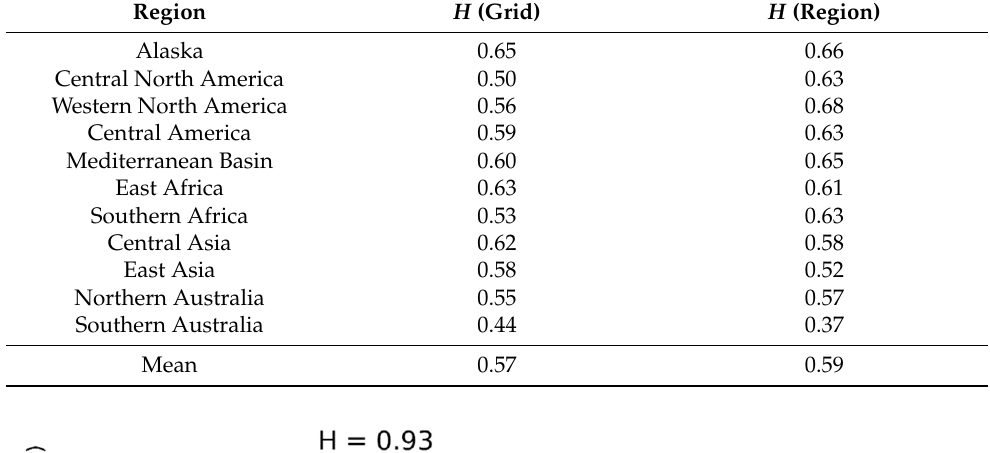
Figure 6. Box plot showing scale dependence of H for the Asian region. Units for x -axis are decimal degrees.